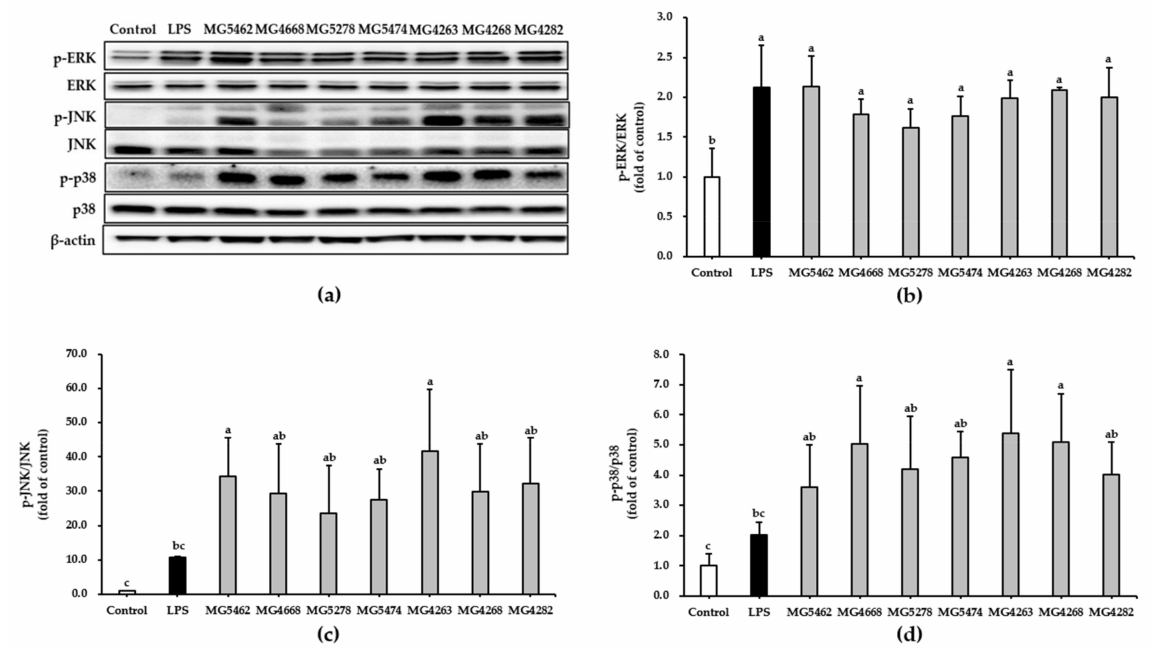
Figure 5. Effect of CFS from LAB strains on MAPK activation in RAW264.7 cells. Cells were treated with LPS (10 ng/mL) or CFS (5 mg/mL) for 24 h. Representative Western blot ( a ) and the